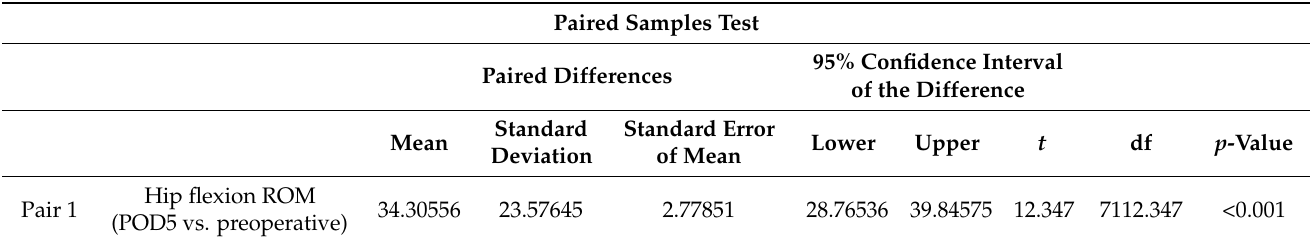
Table A3. The parametric test to analyse the mean maximally tolerable hip flexion before procedure and on post-procedural Day